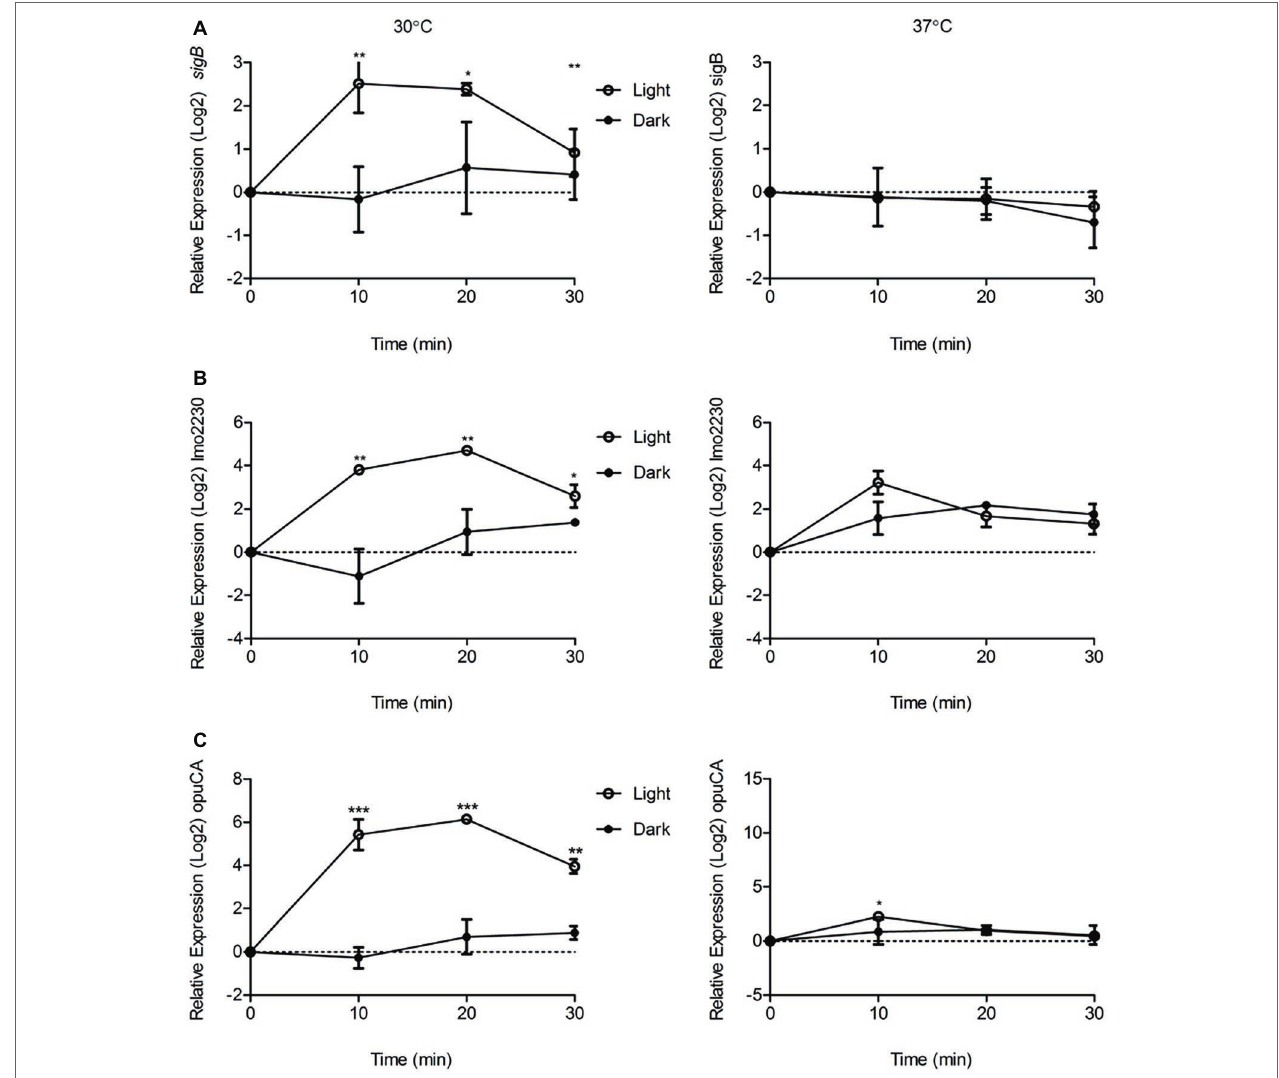
FIGURE 2 | Exposure to visible light significantly increases the transcription of sigB , lmo2230 , and opuCA compared to the dark control at 30 ° C but not 37 ° C. Cells were grown to OD ~ 0.2 at 30 or 37 ° C and exposed to 0.6 mW cm − 2 470 nm light for 30 min at the same temperature, with RNA samples collected at 10 min intervals. Relative transcription of sigB (A) , lmo2230 (B) , and opuCA (C) was measured by RT-PCR. Error bars represent SD from two independent replicates. Statistical significance was determined by a paired t -test. (* p ≤ 0.05; **** p ≤